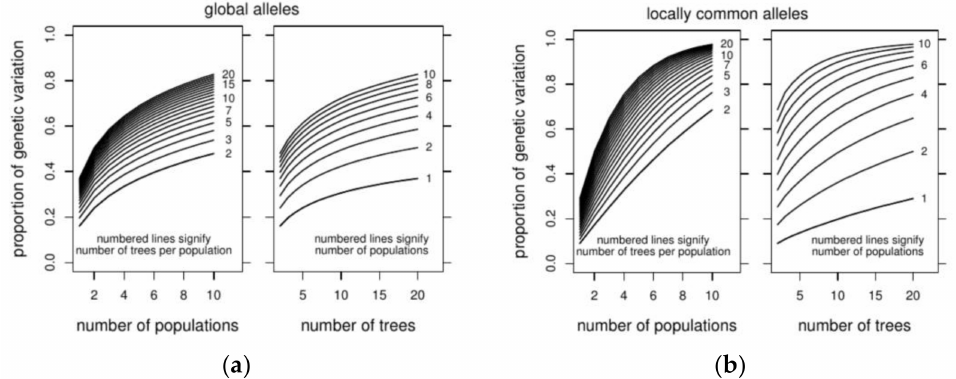
Figure 3. Accumulation of genetic variation as more populations or trees are added. The two plots in panel ( a ) represent “global alleles” (i.e., all alleles) and the two in panel ( b ) “locally common” alleles. In the graphs with number of populations on the X axis, the successive lines are additional numbers of trees per population; likewise, in the graphs with number of trees on the X axis, the lines are additional numbers of populations those trees are sampled